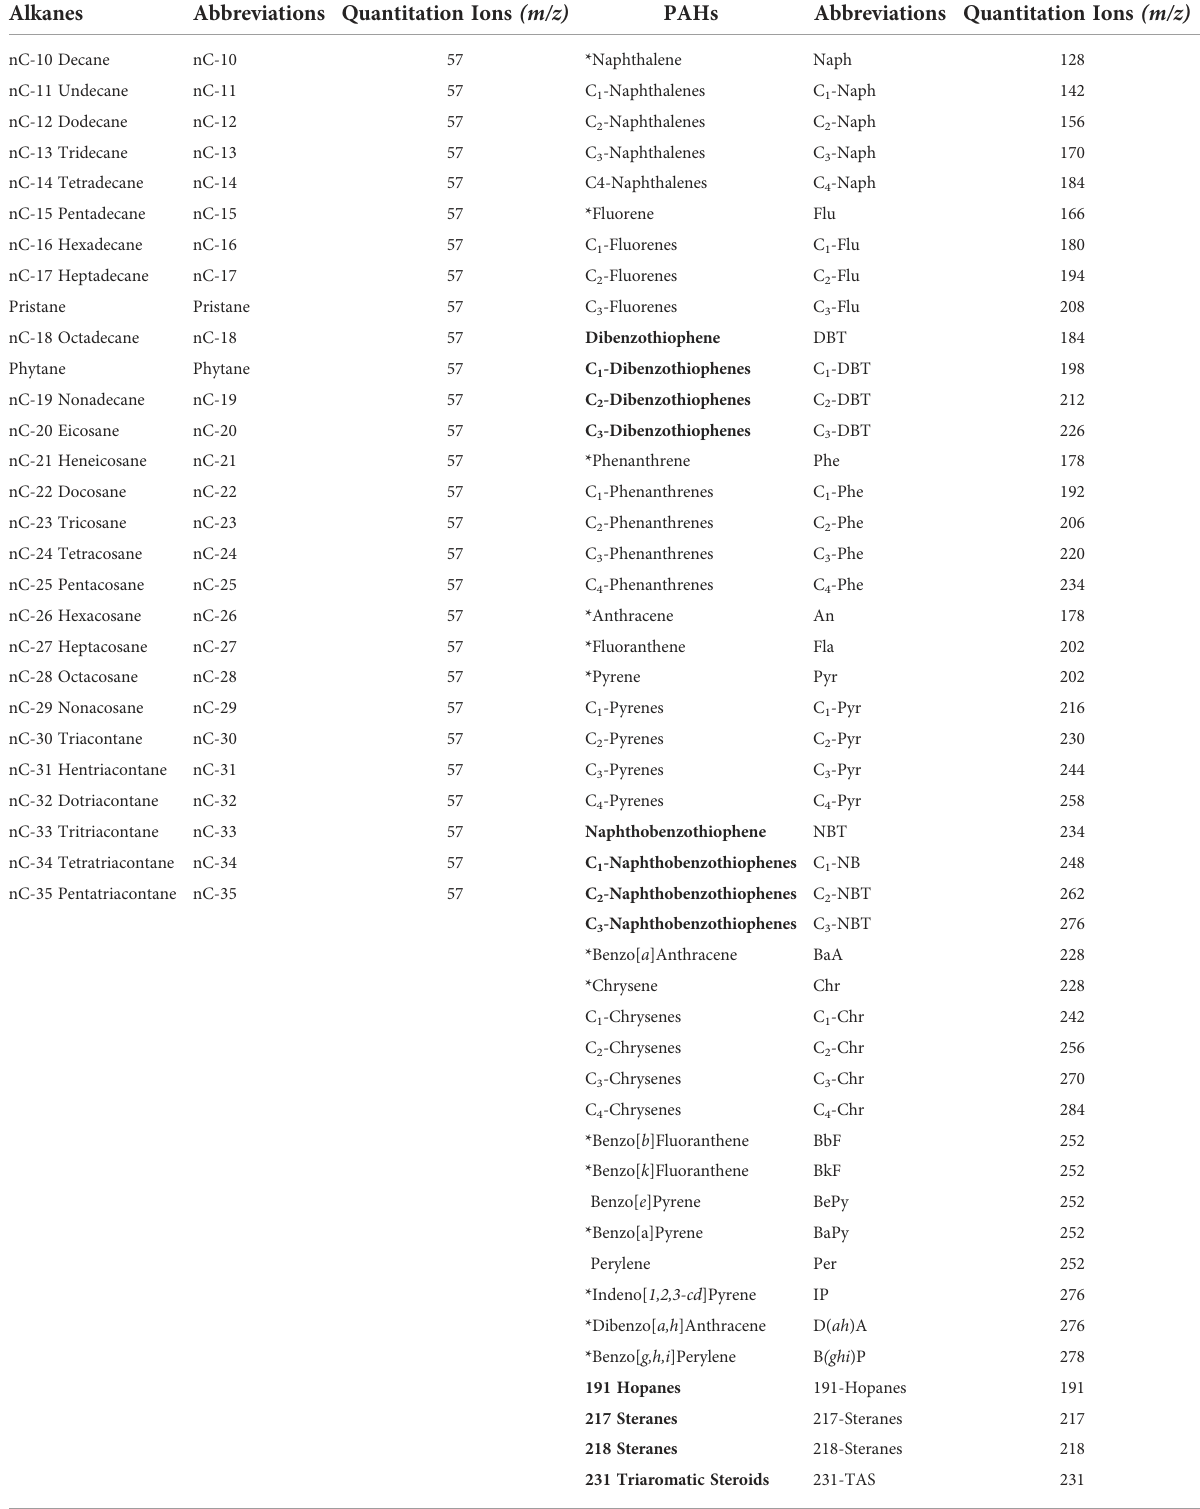
TABLE 1 Quantitation ions for Parent and Alkyl Homolog PAHs, Alkanes, and Biomarker Compounds in Crude Oil. Alkanes Abbreviations Quantitation Ions (m/z) PAHs Abbreviations Quantitation Ions